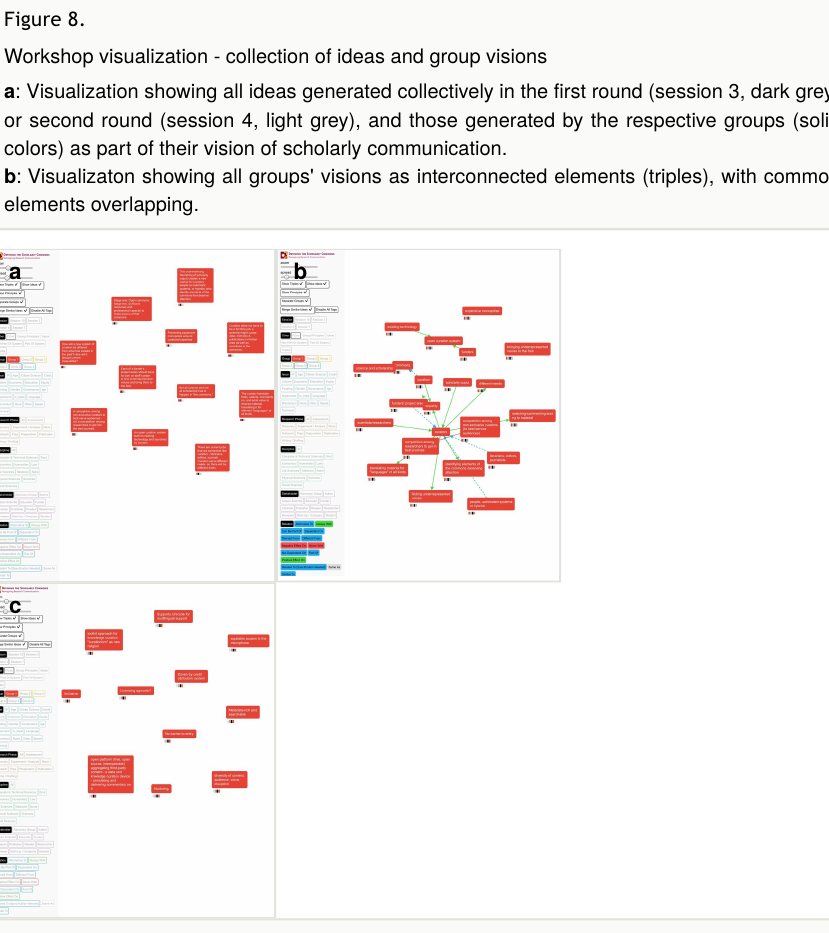
Figure 9. Visualization showing one example of development of a group's vision and progress to group